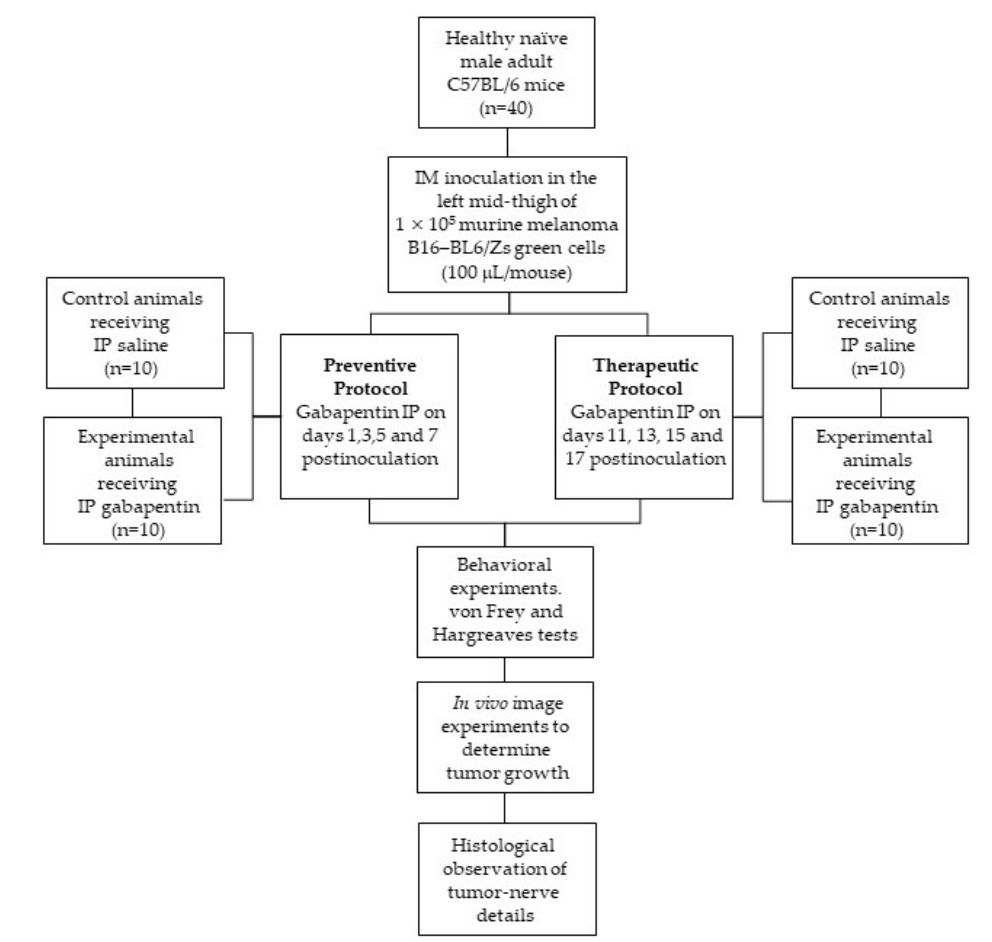
Figure 8. Summary of the in vivo experimental protocol.